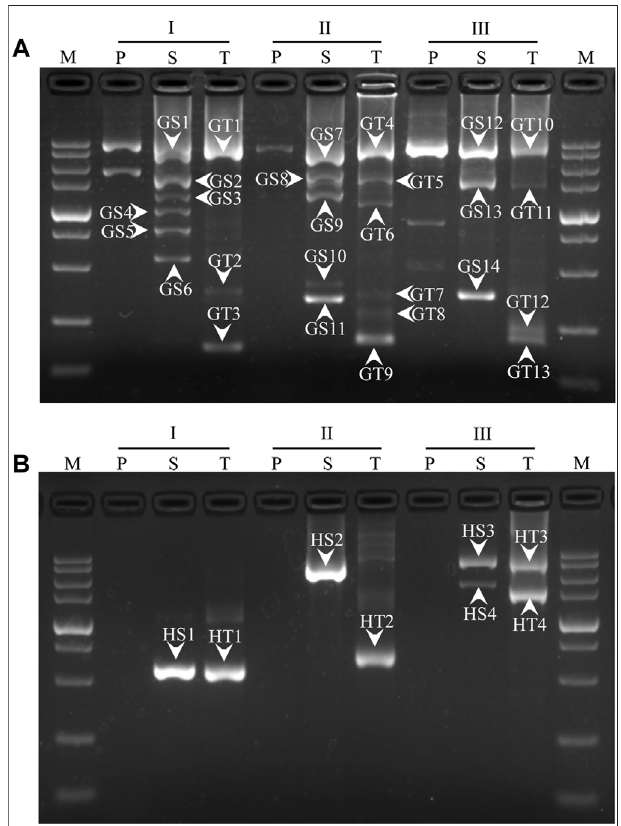
FIGURE 2 | Genome walking for gadA of L. brevis CD0817 (A) and hyg of rice (B) . I, II, and III represent three sets of WW-PCRs in a walking, individually participated by the three WWP permutations, as indicated in Table 2 ; lanes P, S, and T represent primary, secondary, and tertiary PCRs, respectively; bands GS1-GS14 and GT1-GT13 indicate secondary andtertiaryPCRproductsfor gadA ,respectively;andHS1-HS4andHT1-HT4 indicate secondary and tertiary PCR products for hyg , respectively. The band numbers correspond to those in Supplementary Figure S1 . M: DL 5000 DNA Marker (5000, 3000, 2000, 1500, 1000, 750, 500, 250, and 100